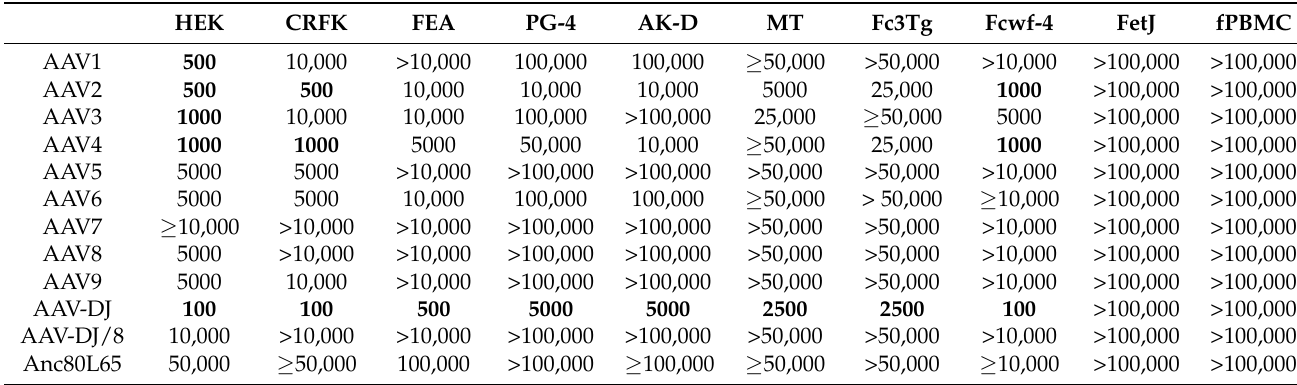
Figure 3. Fluorescent microscopy images of CRFK cells infected with 12 AAV serotypes after three days. Infection of nine natural AAV serotypes (AAV1-9), two AAV hybrid strains (AAV-DJ and AAV-DJ/8), and Anc80L65, all EGFP tagged from the upper left to the lower right, using a multiplicity of infection (MOI) between 100 and 10,000. From the left to the right of each column, the MOI consisted of 100, 500, 1000, 5000, and 10,000, always in duplicates ( N = 2). Red squares mark the minimal MOI, at which a significant AAV infection could be visualized for each AAV serotype by fluorescence (corresponding to ≥ 50% infection). For AAV7, AAV8, AAV-DJ/8, and Anc80L65, no infection could be observed up to an MOI of 10,000. The bars represent 400 µm. Table 2. Summary of in vitro infectivities of various AAV serotypes in different cell lines and fPBMCs depicted as multiplicity of infection (MOI) a .